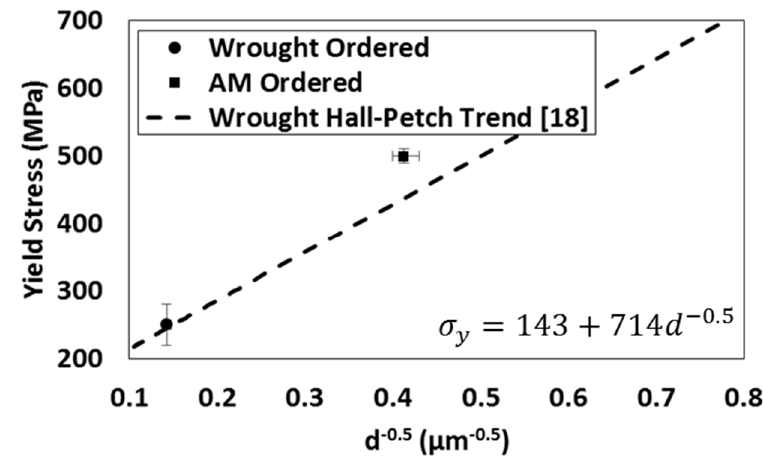
Figure 7. Hall-Petch fit of yield strength for both ordered AM and wrought material.